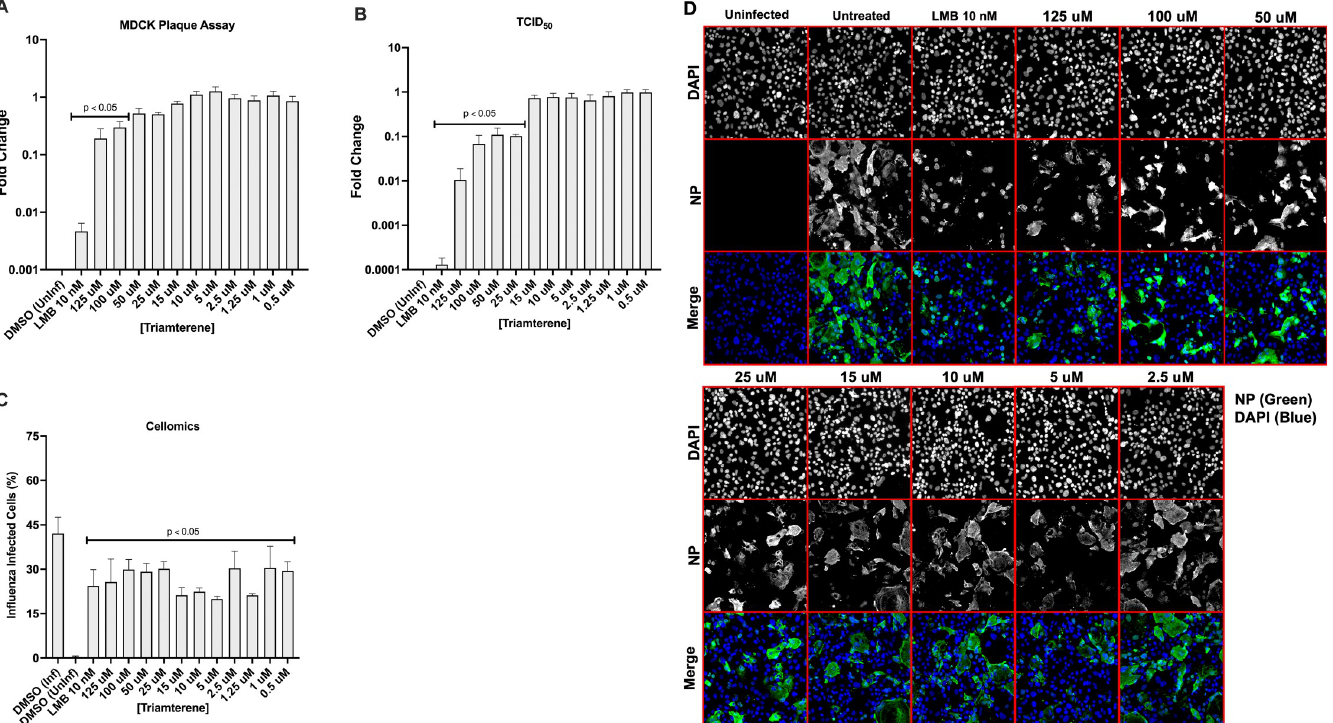
Fig 3. Pretreatment with Triamterene reduces A/WSN/33 replication. Calu-3 cells were pretreated with Triamterene for 24h, or LMB for 2h before infection with A/ WSN/33 (MOI = 0.01). At the time of infection, the media was removed and the virus was added with drug replenishment. The infection was incubated for 24h. Post- infection, supernatants were collected and evaluated by plaque assay (A) and TCID 50 assay with HA endpoint (B). Fixed Calu-3 cells were immunostained for NP and with DAPI for Cellomics analysis (C) and imaging (D). The results were determined as means ± standard errors of the means for two independent experiments performed in triplicate. Statistically significant differences from DMSO-treated controls were determined by one-way analysis of variance with Dunnett’s multiple- comparison test (p < 0.05) and are indicated on graphs where appropriate. Influenza NP is green; nuclei are blue.